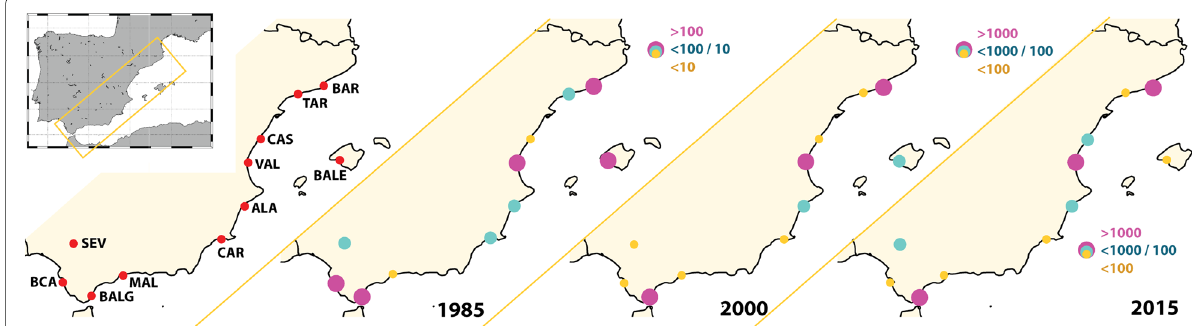
Fig. 1 Location of the SpanishMed ports and container throughput (in 1000 TEU) for 1985, 2000 and 2015. Note that the container throughput range differs between 1985 and 2000/2015. Ports are identified as follows: ALA (Alacant/Alicante), BALG (Bahía de Algeciras or Algeciras Bay), BCA (Cádiz Bay), BALE (Balearic Islands), BAR (Barcelona), CAR (Cartagena), CAS (Castelló/Castellón), MAL (Málaga), SEV (Sevilla), TAR (Tarragona), VAL